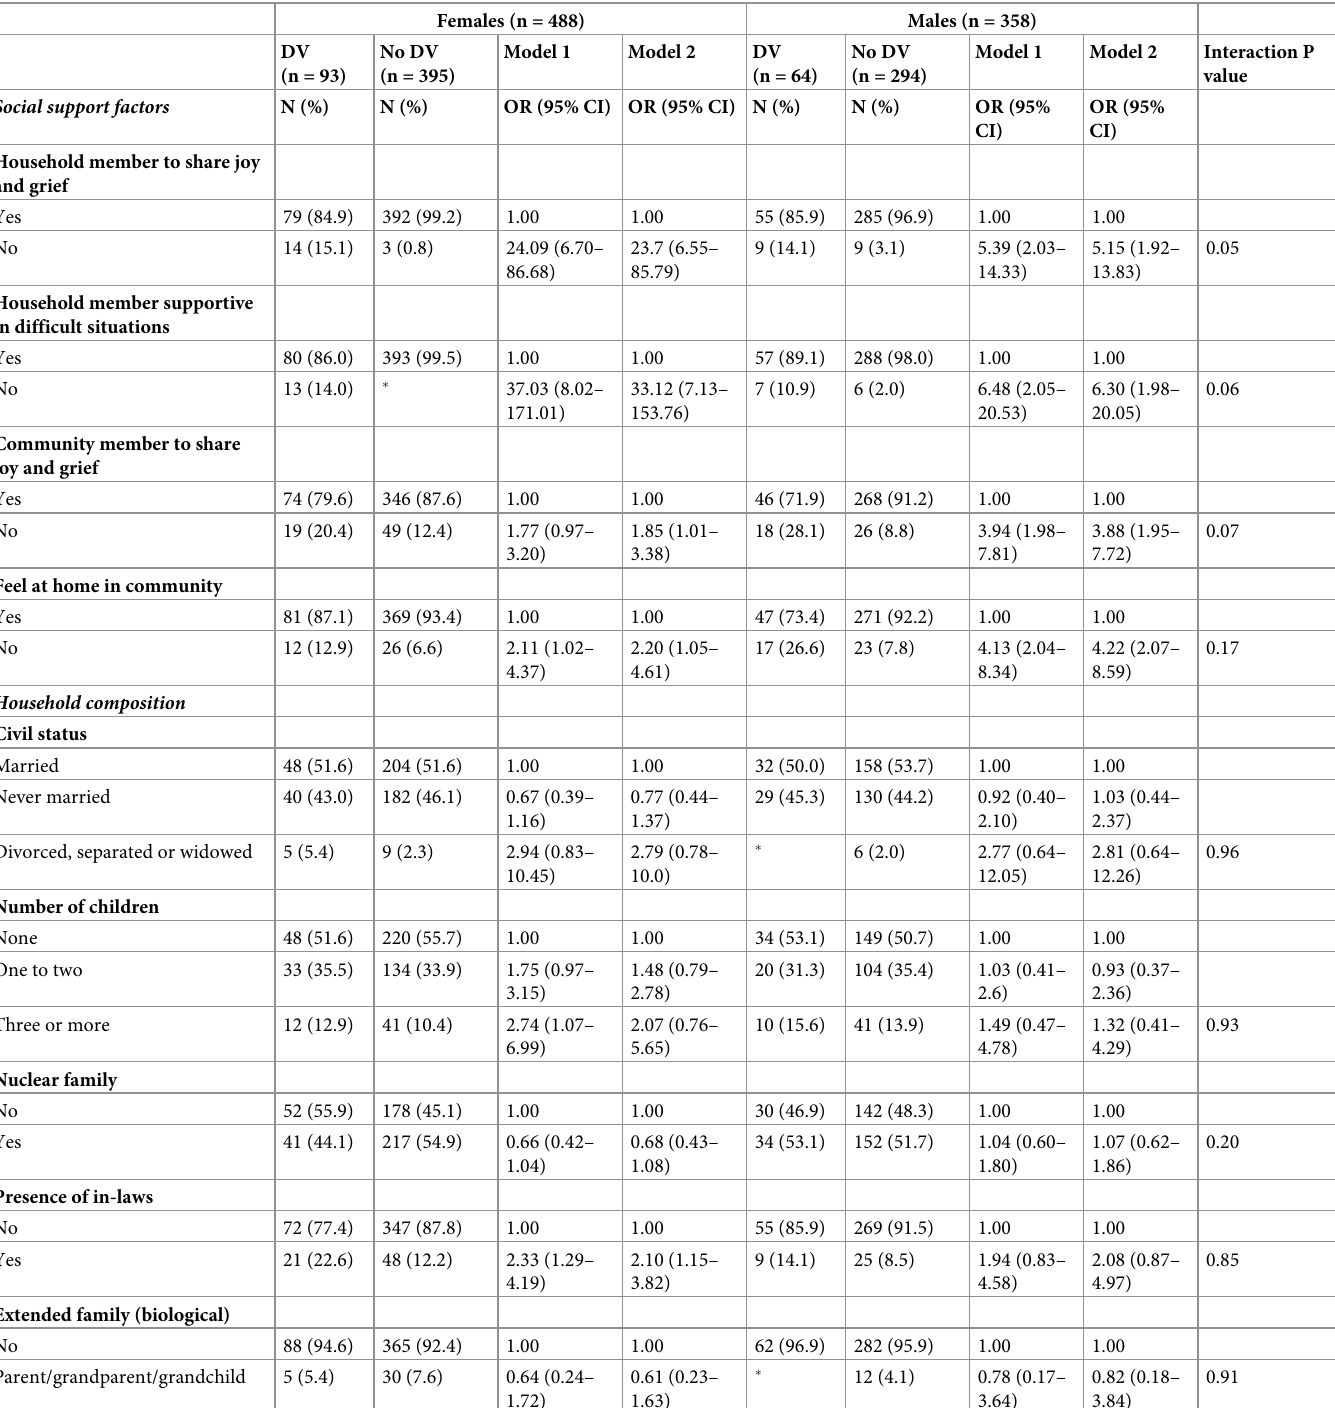
Table 4. Psychosocial factors associated with domestic violence (DV) in Kandy, Sri Lanka, stratified by